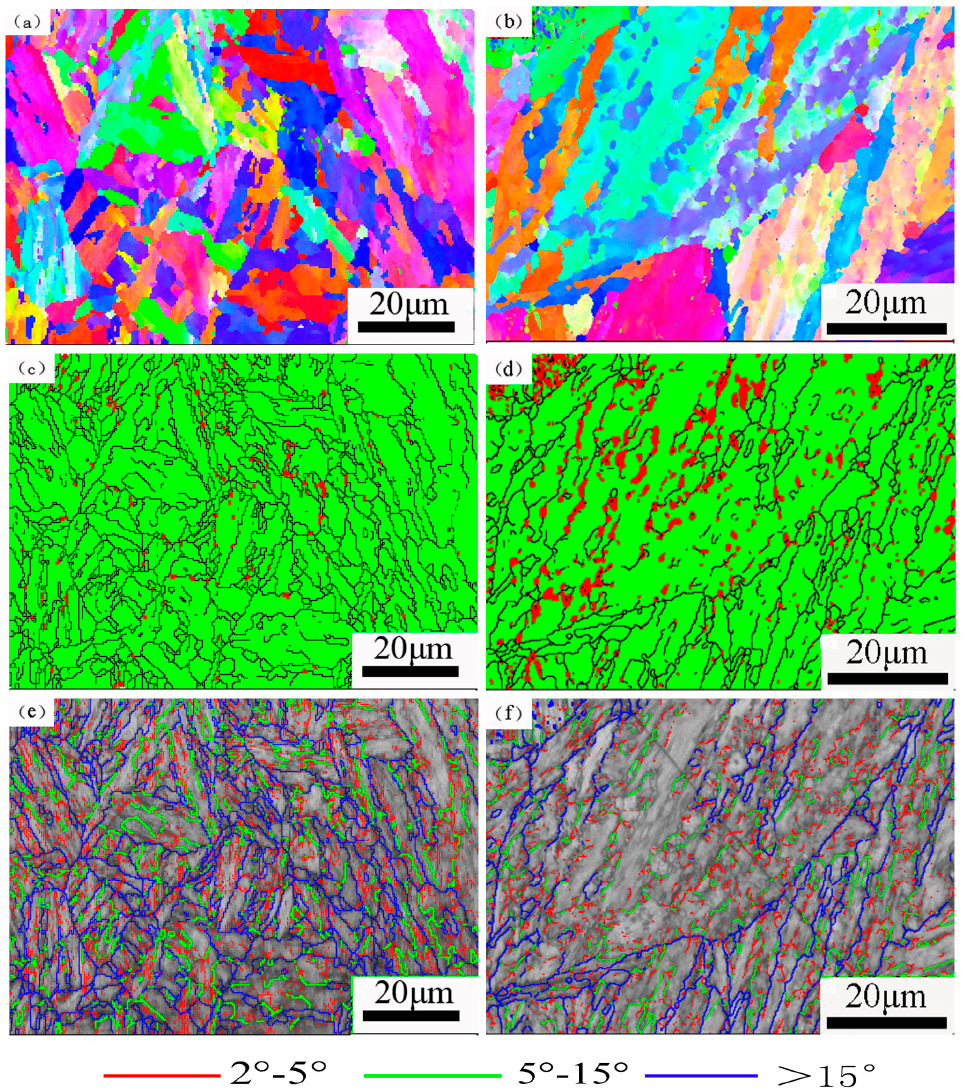
Figure 4. EBSD analysis results of the samples tempered for 2 h and 32 h, respectively: ( a , b ) the inverse pole figure map of reverted austenite and martensite; ( c , d ) phase distribution of martensite and reverted austenite; ( e , f ) high and low angle grain boundaries with misorientation angles.